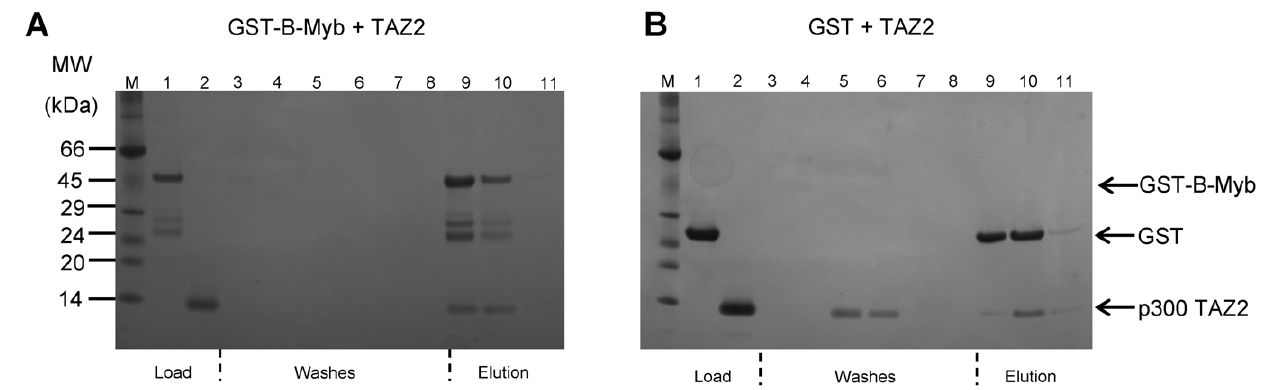
Figure 4. Binding of the B-Myb TAD to the TAZ2 domain of p300. The SDS-PAGE gel shown in panel A illustrates the analysis of a typical pull down experiment using immobilised GST-B-Myb TAD as bait and a slight excess of p300 TAZ2 as the potential interaction partner. p300 TAZ2 was loaded onto a glutathione agarose that had been preloaded with a 0.5 ml sample of GST-B-Myb TAD (32.5 m M), the column was washed with 8 column volumes of binding buffer prior to elution. Lane M contains molecular weight markers, lane 1 contains the GST-B-Myb load, lane 2 the p300 TAZ2 load, lanes 3–8 are consecutive washes, and lanes 9 to 11 are consecutive elution fractions. The SDS-PAGE gel shown in panel B shows the results of a control pull-down assay in which p300 TAZ2 was loaded onto the column in the presence of GST alone. The samples loaded on the gel are identical to those described in panel A, except lane 1 contains the GST load.